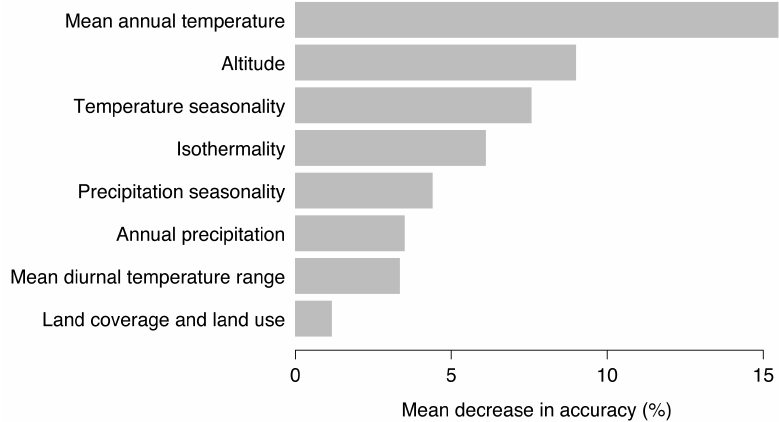
Figure 5. Ranking of the eight used environmental variables according to the mean decrease in